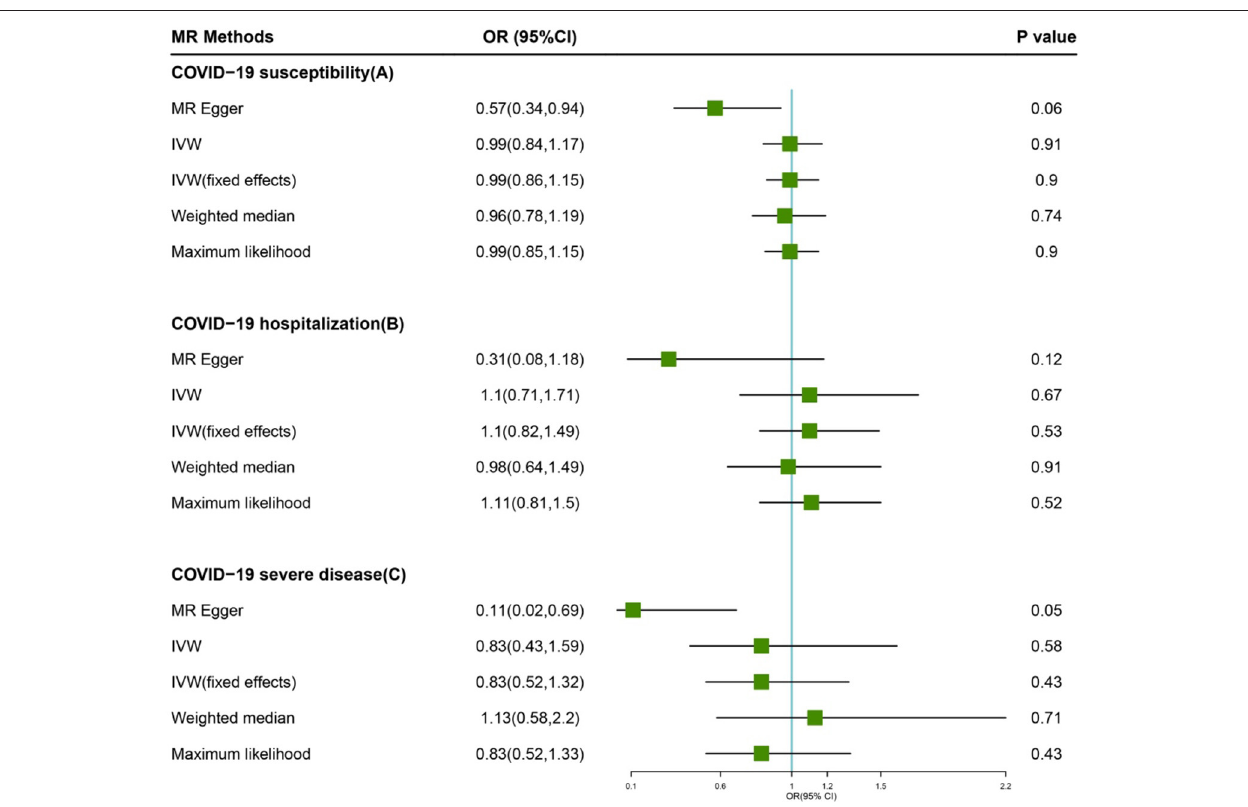
model indicated the absence of outliers ( Figure 2B ). Based on MR PRESSO analysis, we found an SNP (rs11242457) that was a potential source of heterogeneity ( Supplementary Figure 3